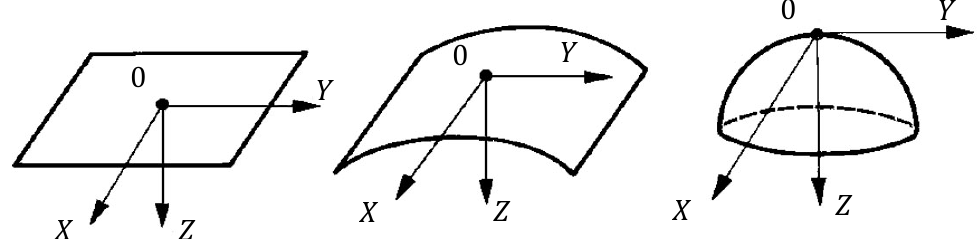
6 of 21 Figure 3. Simple schematics for calculation of illuminance produced by flat PMTS. The first term of Series (13) describes the LED irradiation nearest to the point K . As the distance from the irradiating surface increases, new terms occur in the series due to obvious overlapping of light beams. This equation shows that theoretical determination of illuminance at an arbitrary point requires complicated calculations and unjustified simplifications. It is more appropriate to determine the LED light distribution over a surface of a certain type generated by one of the aforementioned types of PMTS or combinations of them. Also, it is better to assume that the shape of the irradiated biotissue can be approximated with a flat, cylindrical, or spherical surface. As a result, due to such assumptions, the general task of calculating the LED intensity created by the matrix structure can be divided into several special cases. The illuminance at each point of the irradiated surface is calculated as the summarization of illuminances produced by each LED. In the process of calculation of the contribution of each LED the coordinate system is translated so that the origin of coordinates coincides with the LED under consideration, whereas the Z -axis is directed along the optical axis of the diode source (in the direction of light distribution). Thus, if coordinates ((cid:1876) (cid:2868) , (cid:1877) (cid:2868) , (cid:1878) (cid:2868) ) of the point K in the new coordinate system are determined, then the illuminance is calculated using Formulas (1), (2) and (3). Such a basic coordinate system was selected to simplify the specification of parameters of the irradiated surface. Now, based on all of the aforementioned assumptions, let us consider several main methods of illuminance calculation produced by PMTS of various types. Flat PMTS (Figure 4, left). For the flat type of PMTS the calculation begins from the upper left LED. In this case, the coordinates of the irradiated point are: